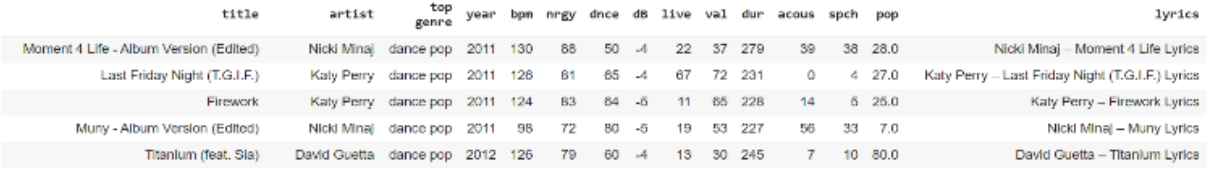
Figure 2. Hot 100 Billboard Songs Dataset after extraction of